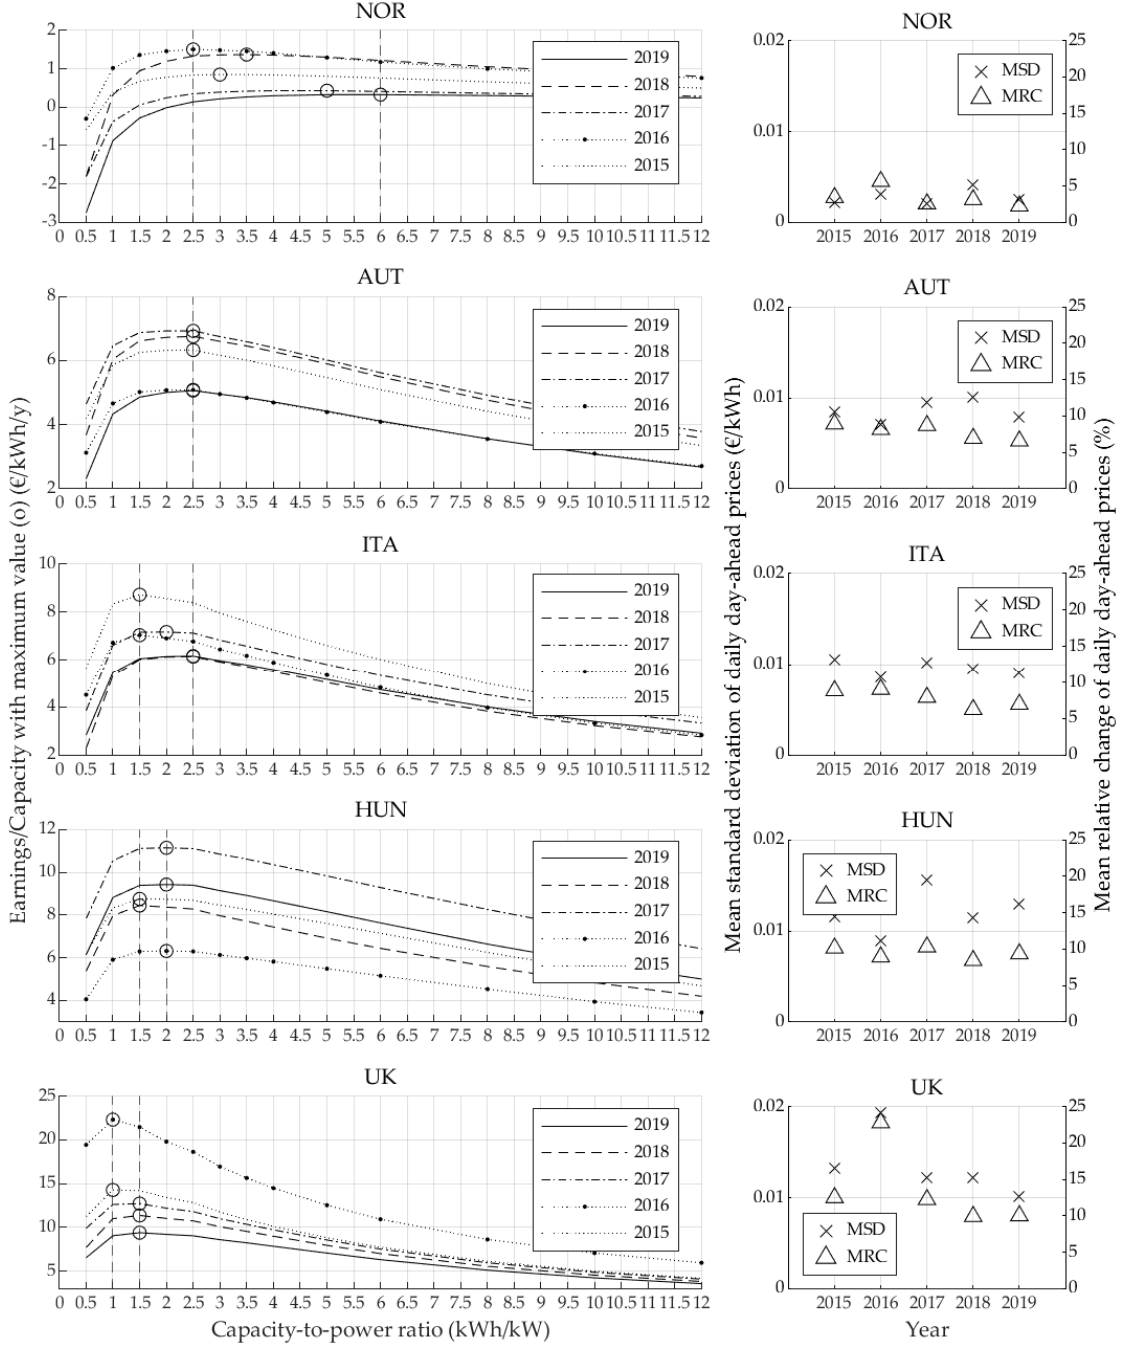
Figure 4. Economic potential for Norway (NOR), Austria (AUT), Italy (ITA), Hungary (HUN), and the United Kingdom (UK) based on different capacity-to-power ratios with the yearly max value (o), as well as the yearly mean standard deviation (x), and the yearly mean relative change ( △ ) of the different daily day-ahead prices for the years 2015–2019.